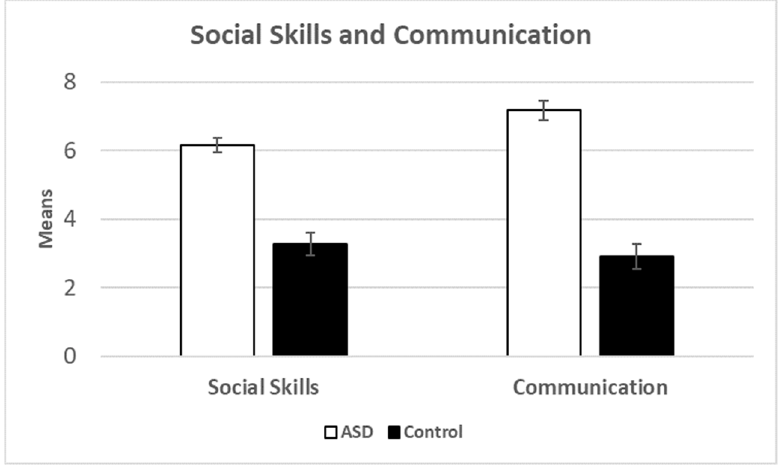
Figure 4. Means for social skills and communication broken down by group. Error bars show the standard error of the mean.